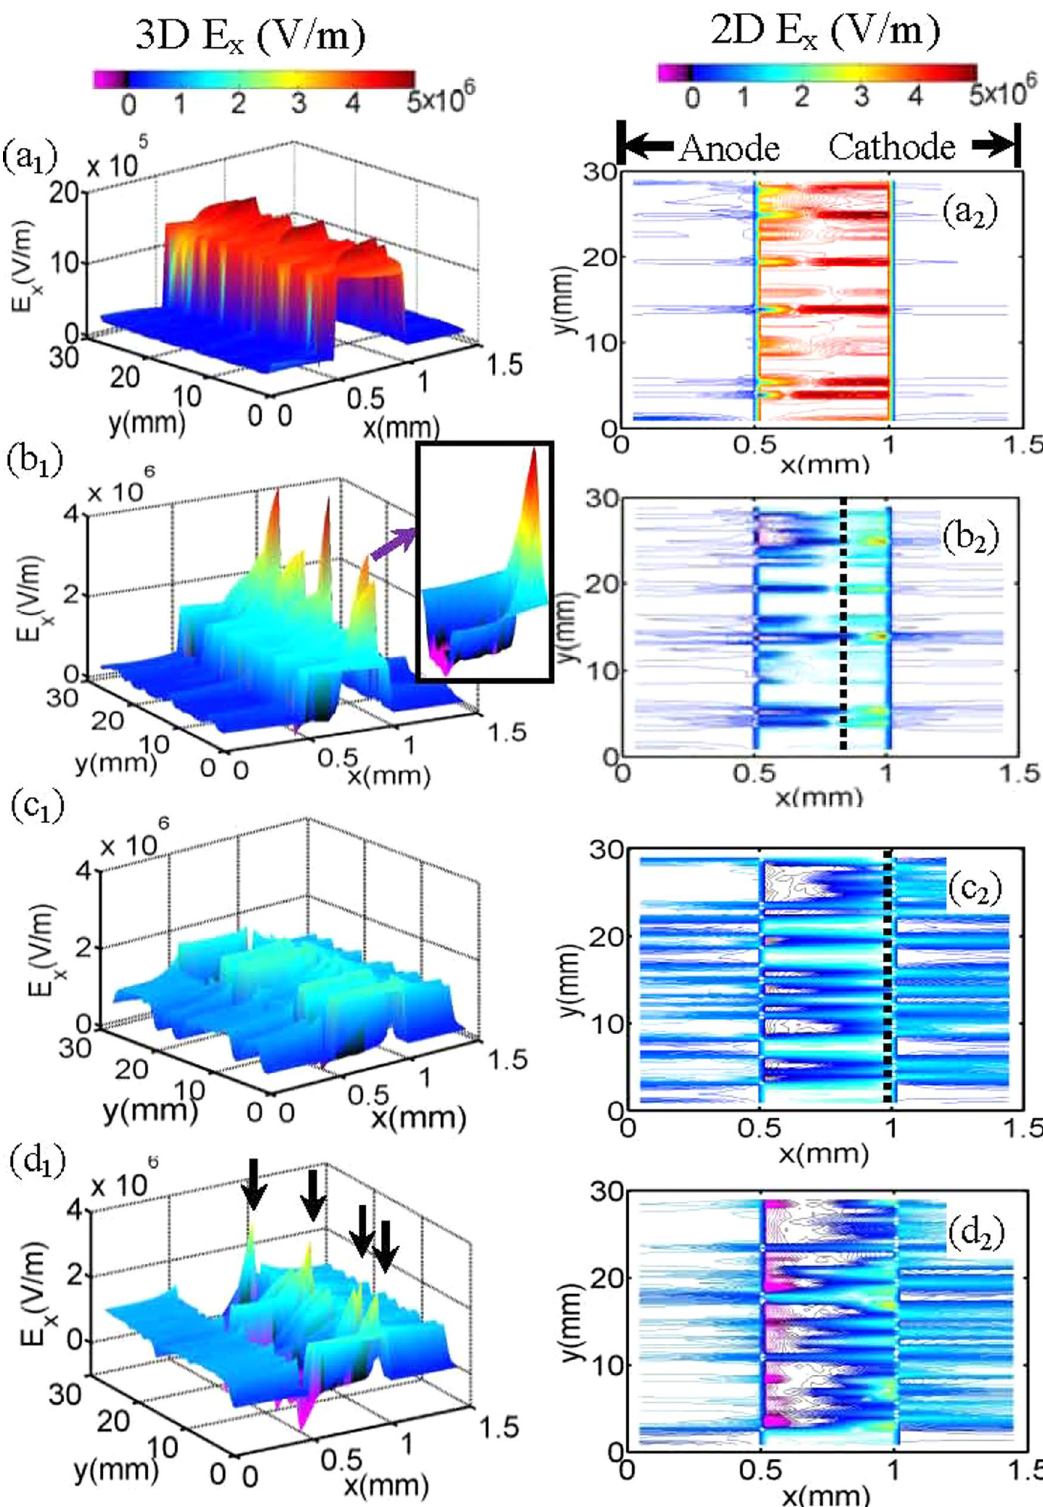
Figure 4. Evolution of E x as the discharge proceeds. The first column shows the 3D E x profiles while the second column presents the corresponding contour graphics. The E x profile at y ∈ [13.4 mm, 14.4 mm] is magnified in the inset nearby. The dashed lines in ( b 2 ) and ( c 2 ) show the edges of the transient plasma sheaths. The black arrows in ( d 1 ) indicate the E x peaks where the side discharges